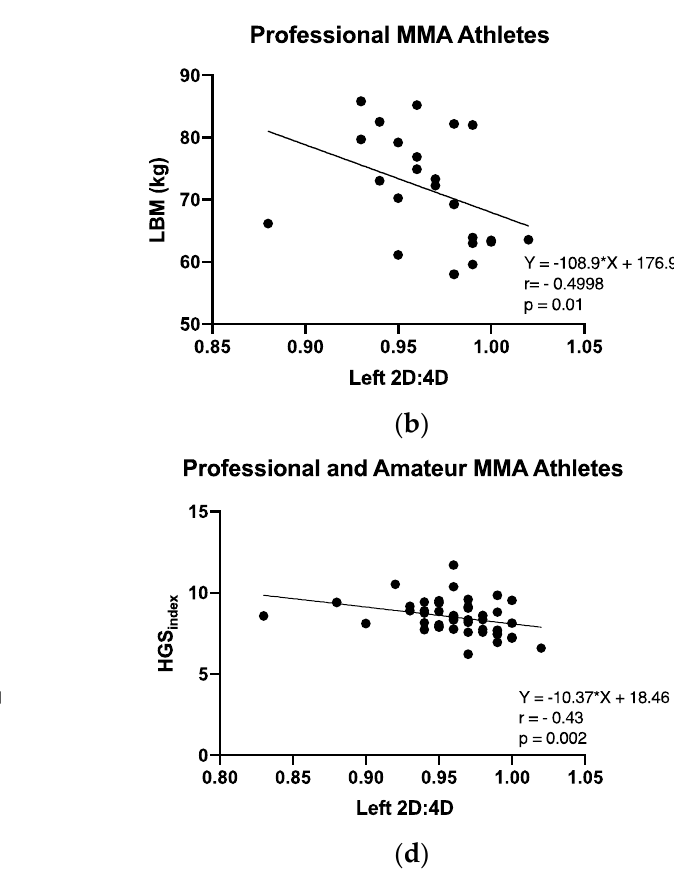
Figure 3. ( a ) Spearman’s correlation test between LBM and right 2D:4D among professional MMA athletes ( p = 0.32. ( b ) Spearman’s correlation test between LBM and left 2D:4D among professional MMA athletes ( p = 0.01). ( c ) Spearman’s correlation test between the HGS index and right 2D:4D among professional and amateur MMA athletes ( p = 0.5). ( d ) Spearman’s correlation test between the HGS index and left 2D:4D among professional and amateur MMA athletes ( p = 0.002).